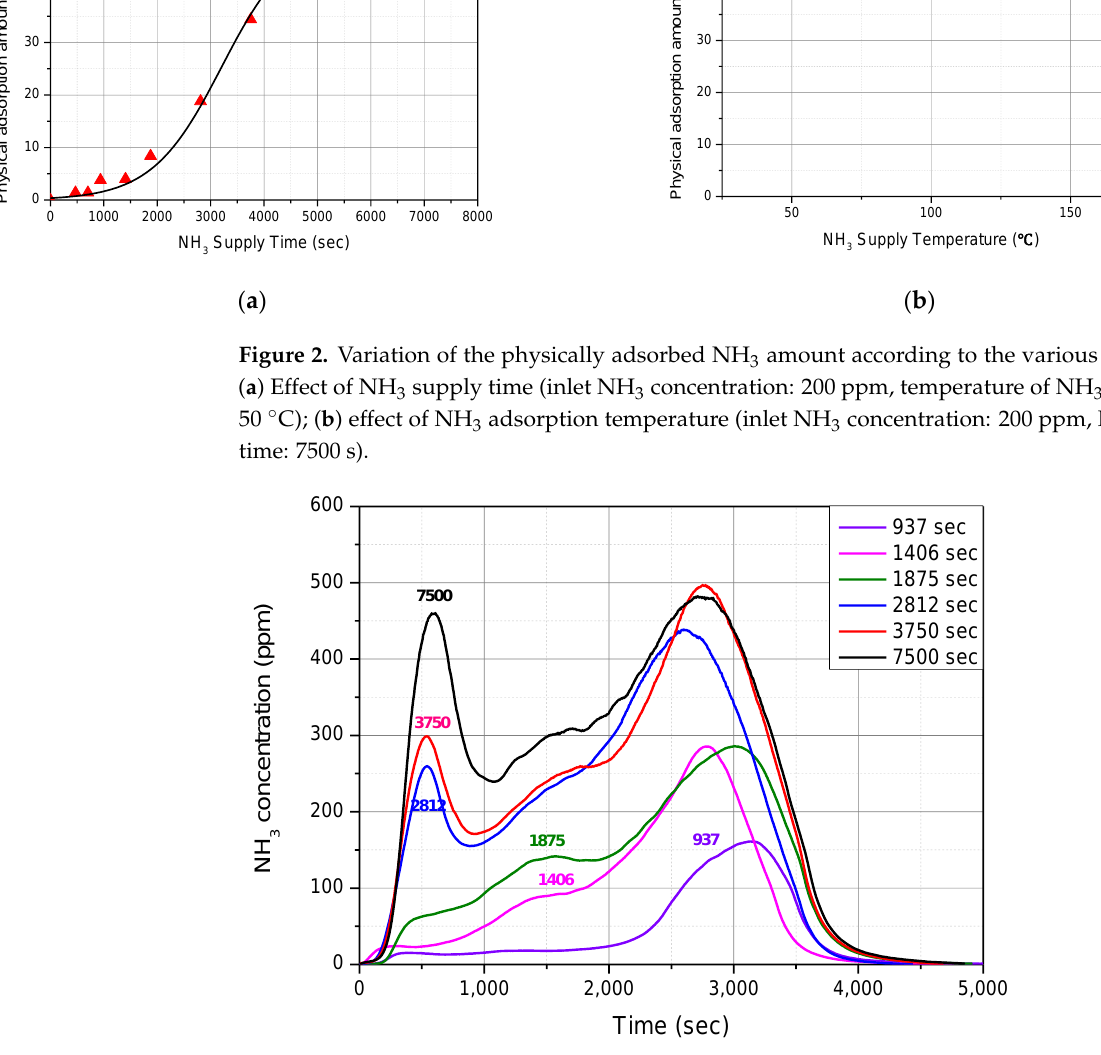
Figure 3. Variation of NH 3 -TPD curves with respect to the NH 3 supply time (inlet NH 3 concentration: 200 ppm, temperature of NH 3 absorbing: 50 °C).